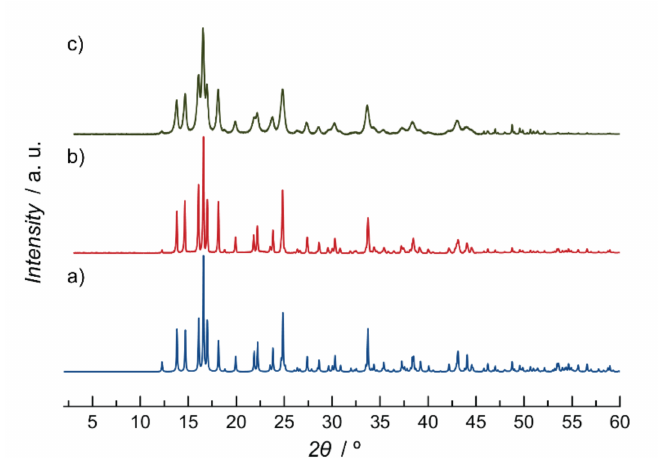
Figure 5. Calculated ( a ) and experimental ( b ) PXRD patterns of 1 in the 2 θ range 2.0–60.0 ◦ at R.T.